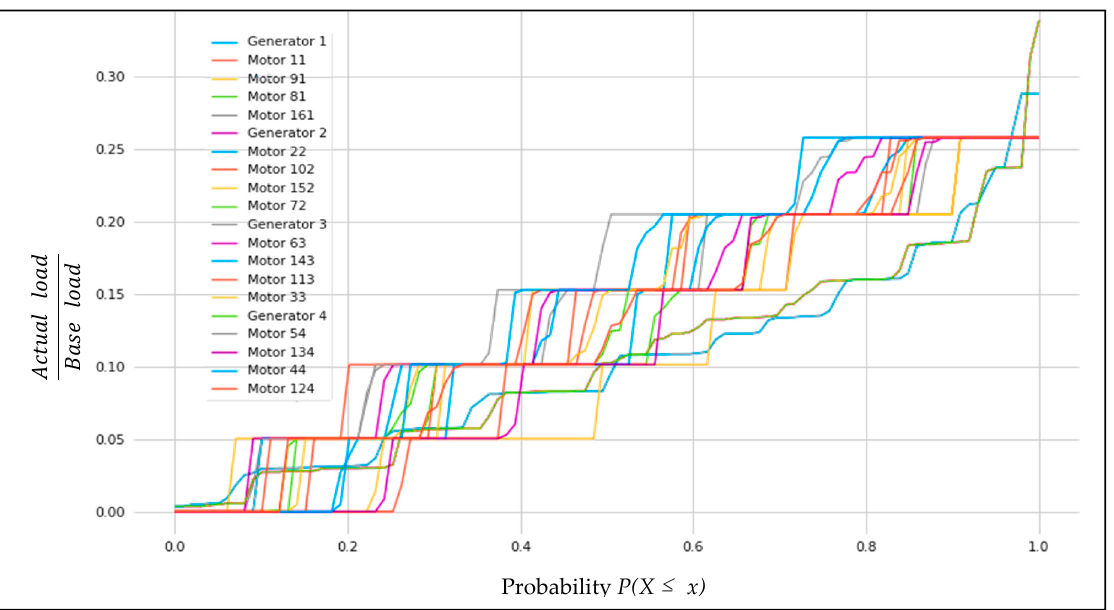
Figure 28. MC TO branch load probability.